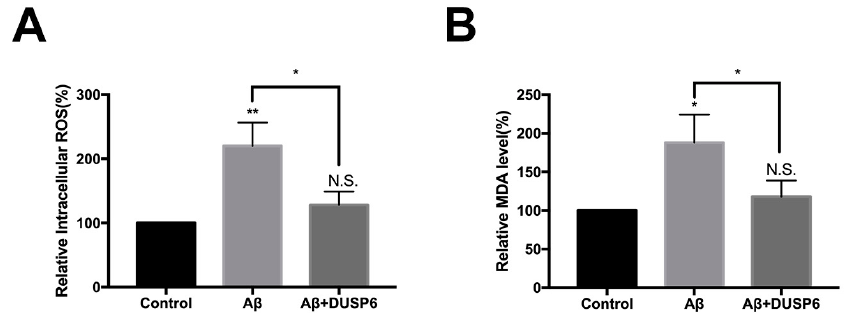
Figure 3. DUSP6 reduced A β -induced oxidative stress in NSCs. NSCs were either transfected with DUSP6 overexpression plasmid or not transfected. Both groups were treated with 5 μ M A β 25–35 for 24 h and then admitted to intracellular reactive oxygen species (ROS) ( A ) and lipid peroxidation marker malondialdehyde (MDA) assay ( B ). The values were normalized to the control group. N.S.: p > 0.05, *: p < 0.05, **: p < 0.01 vs. control. *: p < 0.05 vs. A β 25–35 treated group. n =